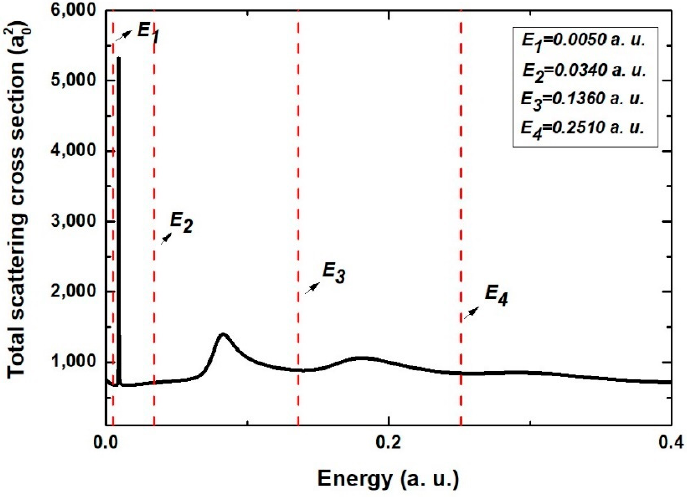
Figure 12. Total e-C 60 elastic cross-section with vertical lines at the off-resonant energies far from the resonance considered for the analysis.